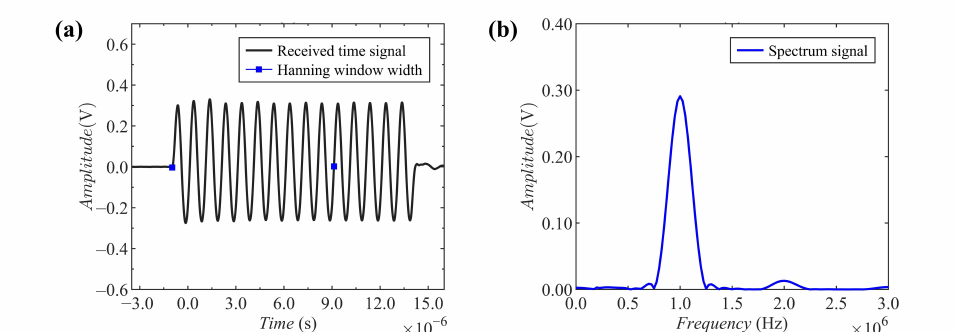
Figure 5. Time signal and spectrum for measurement: ( a ) received time domain signal; ( b ) spectrum signal after FFT ( A 1 : 1MHz, A 2 :